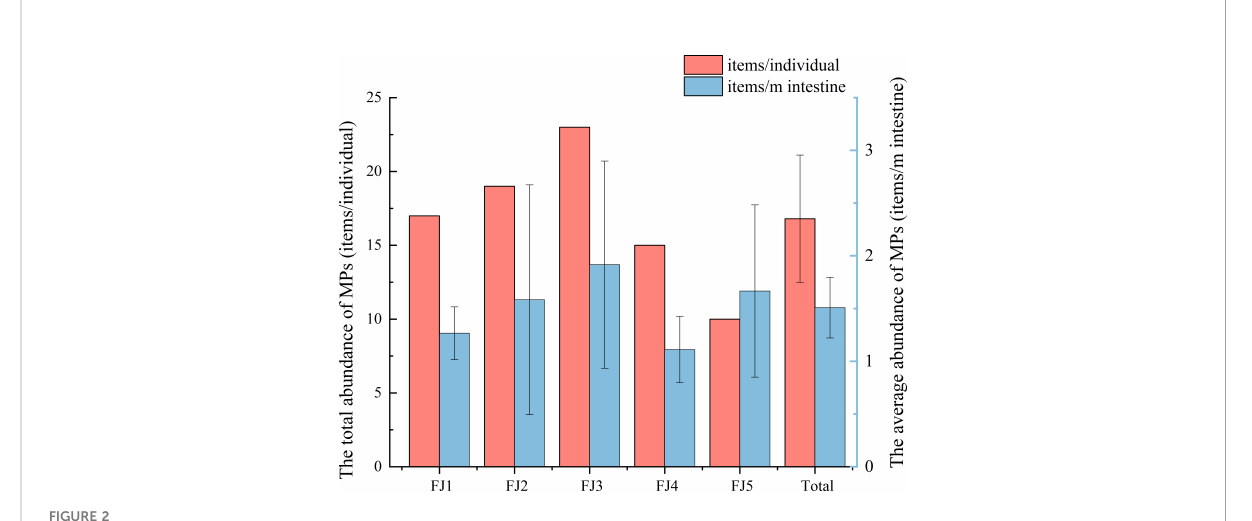
FIGURE 2 The abundance distribution of MPs in each fi nless